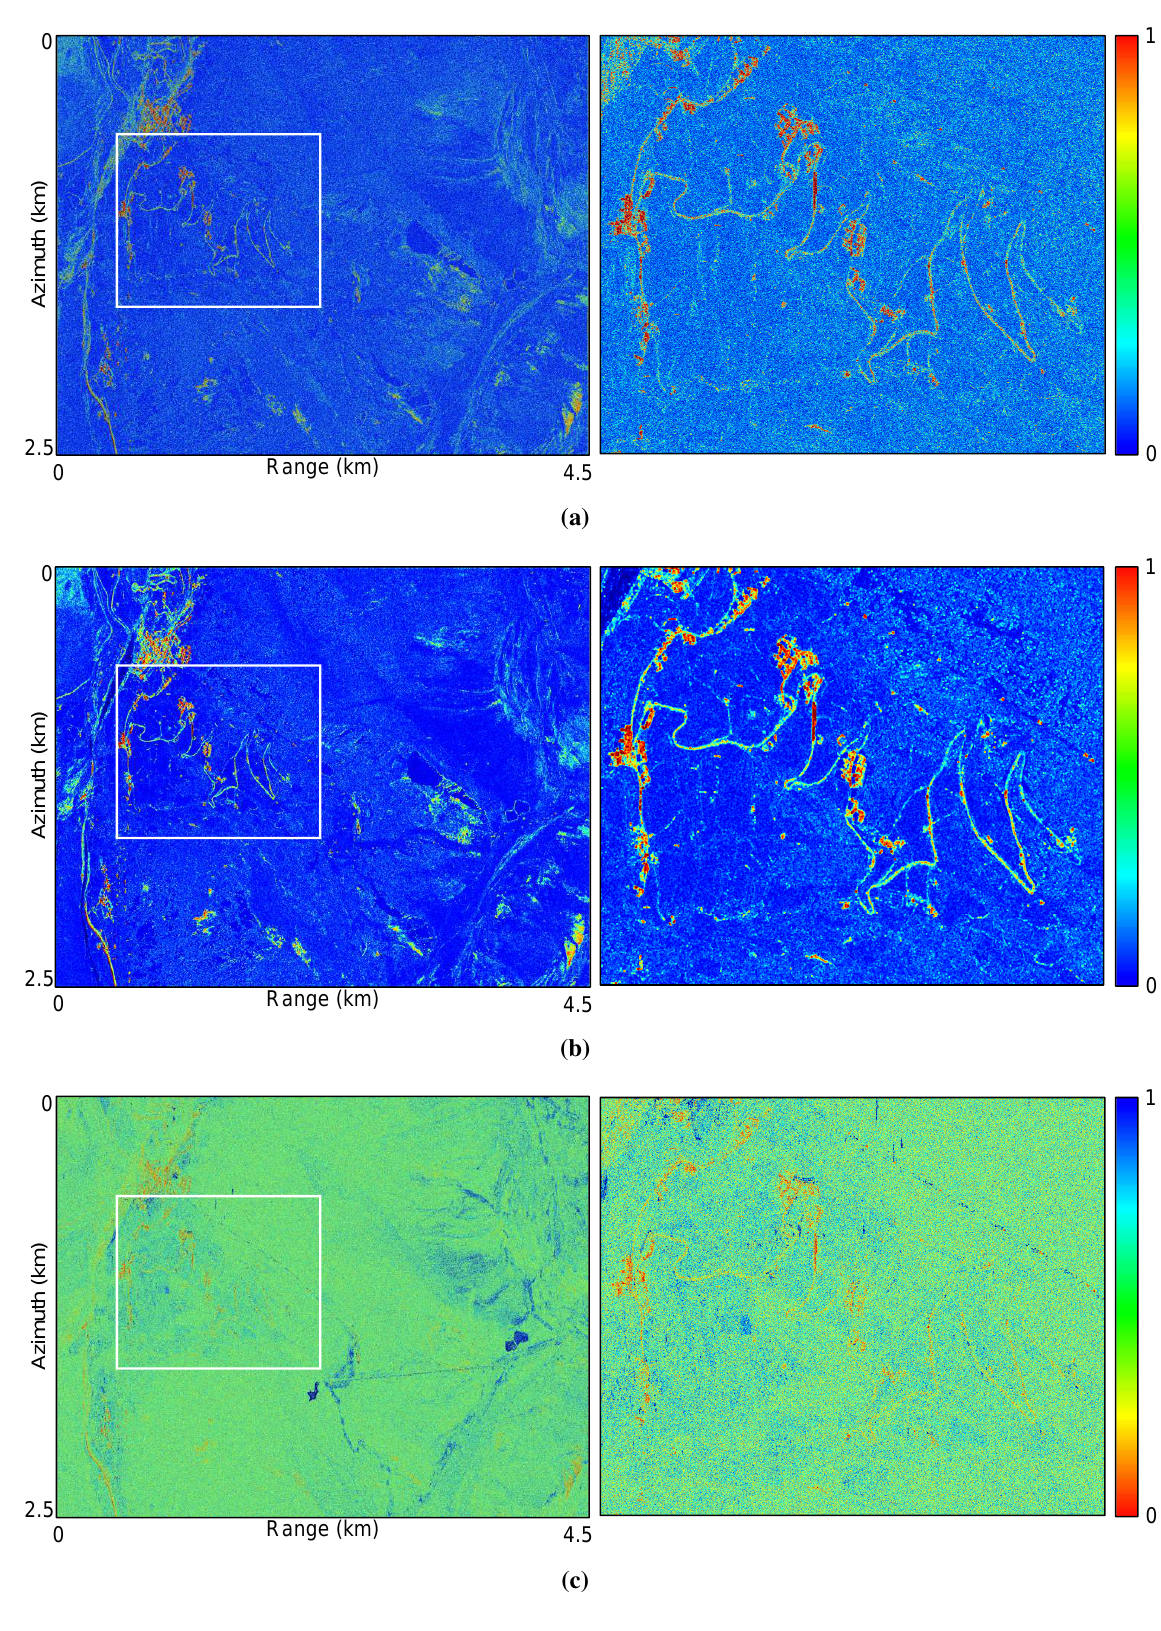
Figure 8. ( a ) TSC; ( b ) mean coherence; and ( c ) D for the sliding Spotlight TerraSAR-X dataset. The figures on the right represent a zoom of the area highlighted with a white rectangle in the figures on the